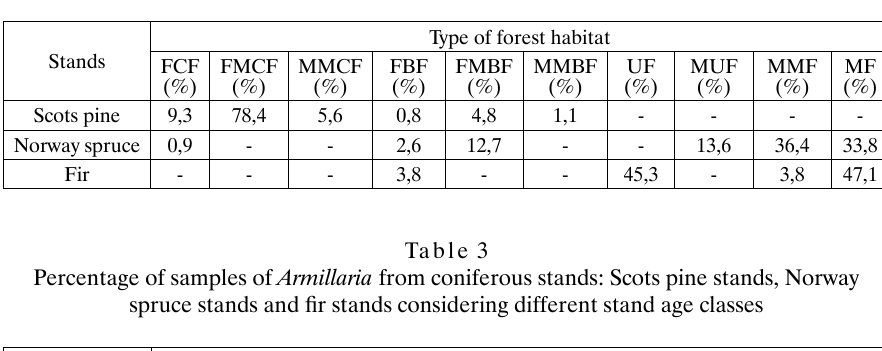
Percentage of samples of Armillaria from coniferous stands: Scots pine, Norway spruce and